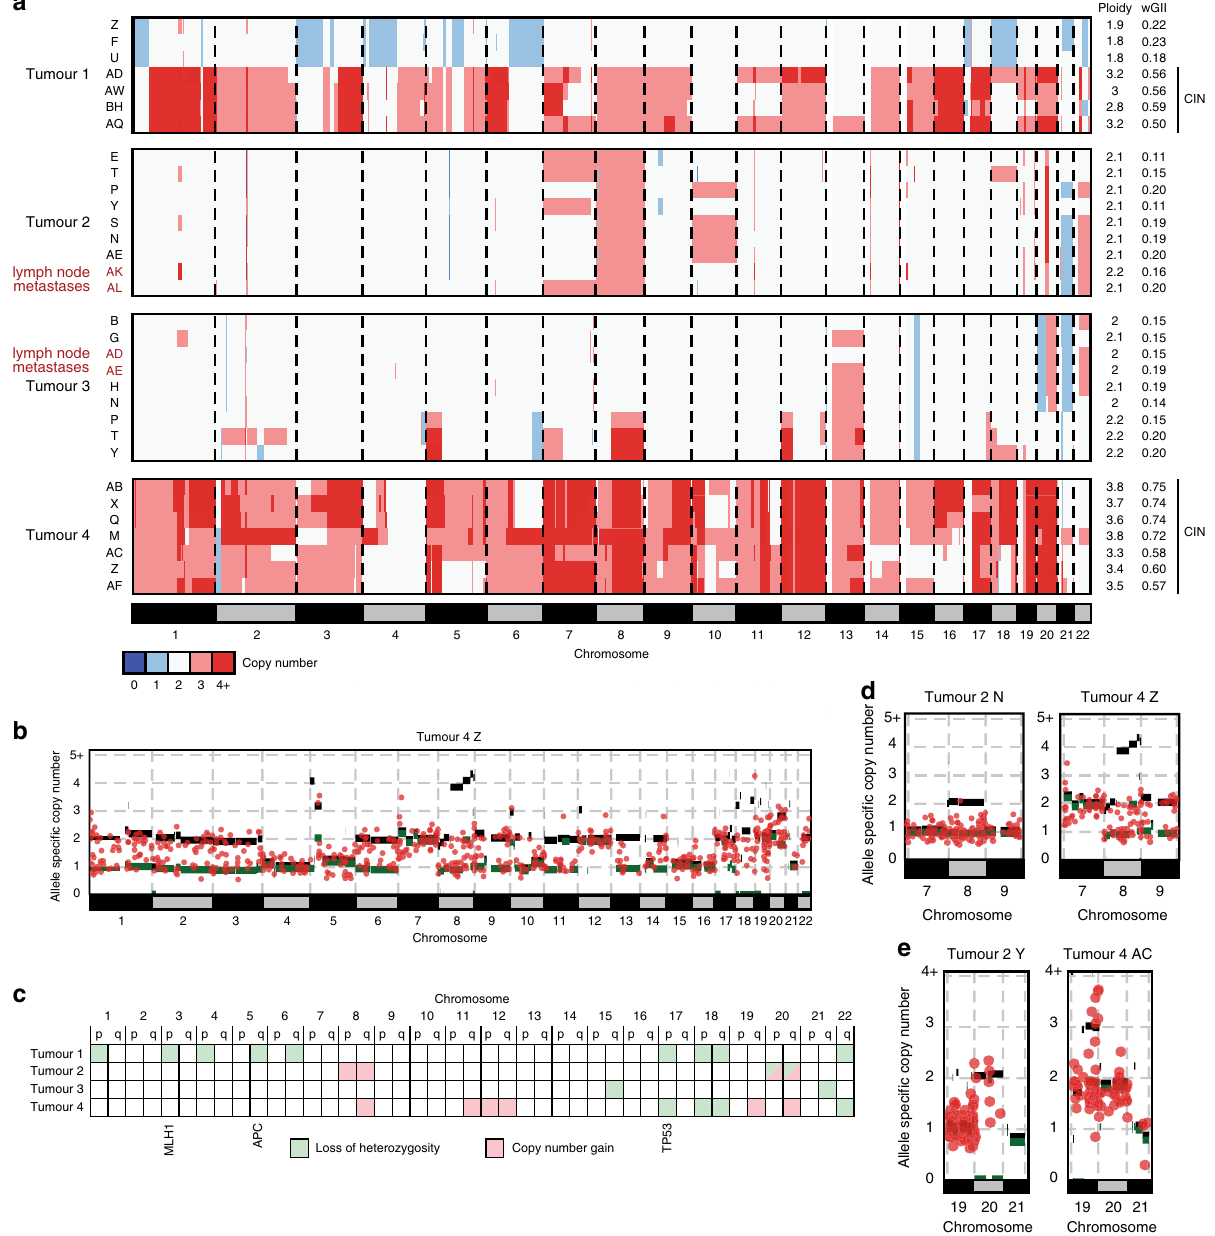
Fig. 2 Intratumour heterogeneity of DNA copy number aberration. a Genome-wide DNA copy number pro fi les of each tumour region. Pro fi les showing chromosomal instability (CIN) are labelled with a black bar on the right. b Example of an allele speci fi c DNA copy number pro fi le and superimposed copy numbers of somatic mutations from Tumour 4. This allows timing of CIN/genome duplication, demonstrating late acquisition, as large numbers of mutations are located on the major alleles for most gained chromosomes. c Ubiquitous loss of heterozygosity (LOH) or copy number gains identi fi ed in each of the four tumours. Tumour suppressor genes commonly mutated in dMMR GOAs and which are located on chromosomes showing ubiquitous LOH are labelled. d Examples of the allele speci fi c copy number and copy number of corresponding somatic mutations for Chr8 and e for Chr20 which showed recurrent ubiquitous gains in our